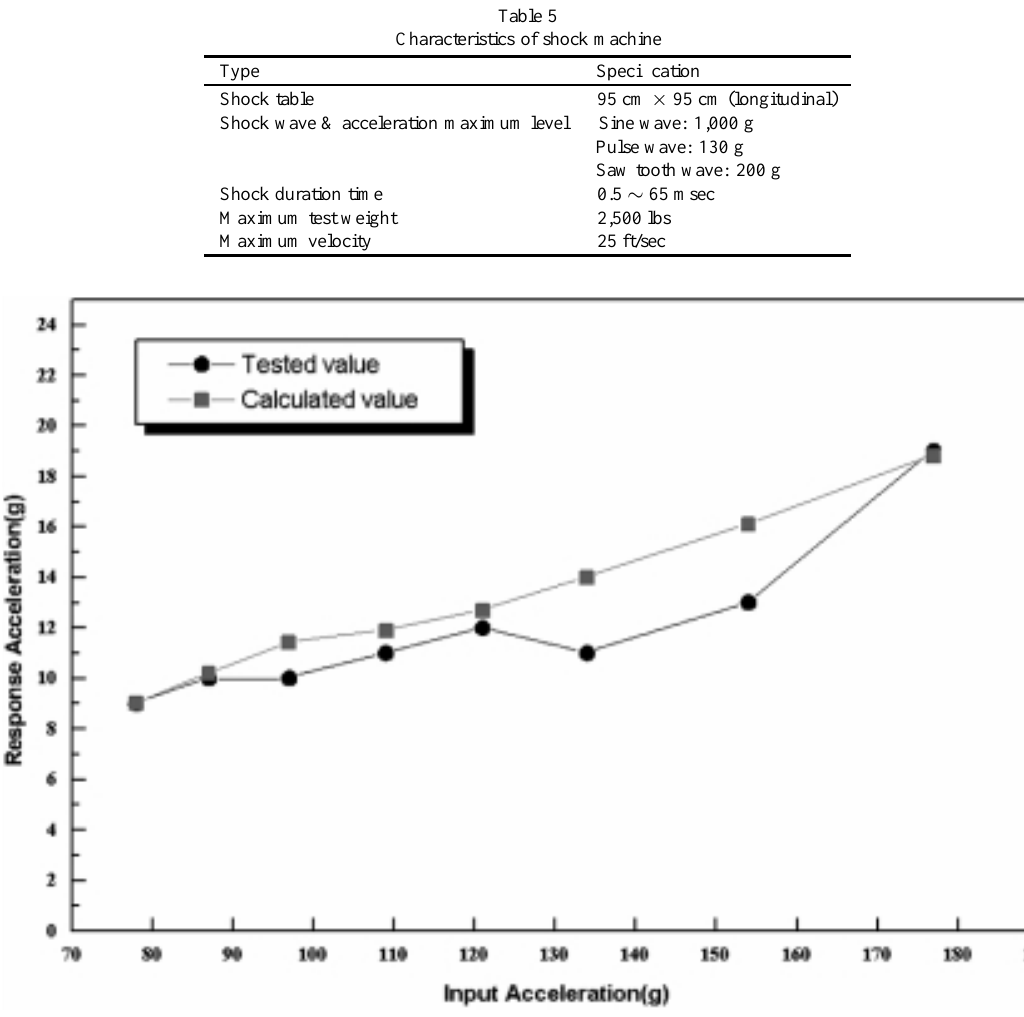
Table 5 Characteristics of shock machine